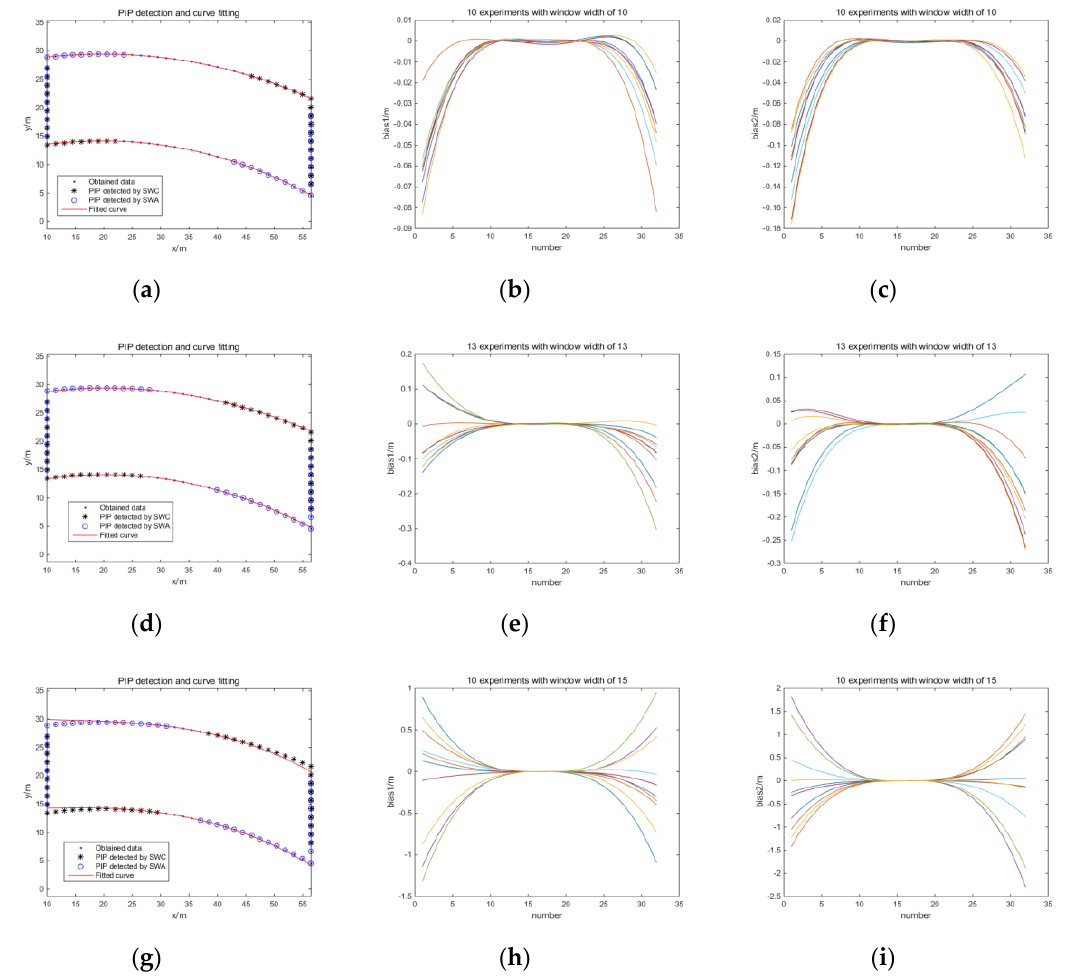
Figure 12. Curved quadrilaterals PCA boundaries under different window sizes. PIP detection with window widths of 10 ( a ), 13 ( d ), 15 ( g ), respectively; deviation of boundary_1 under 10 experiments with window widths of 10 ( b ), 13 ( e ), 15 ( h ), respectively; and deviation of boundary_2 under 10 experiments with window widths of 10 ( c ), 13 ( f ), 15 ( i ), respectively.